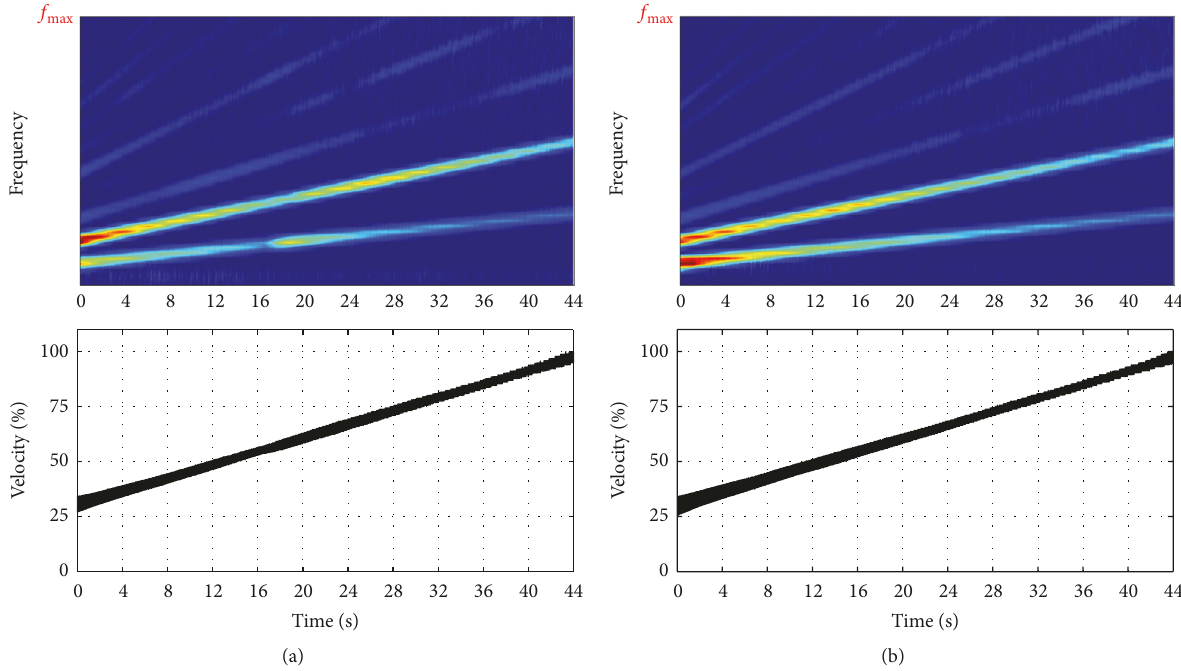
Figure 11: Time-frequency analysis of the crankshaft velocity 𝑛 𝑐 computed for a run-up test: (a) 45 Sh rubber elements and (b) 70 Sh rubber